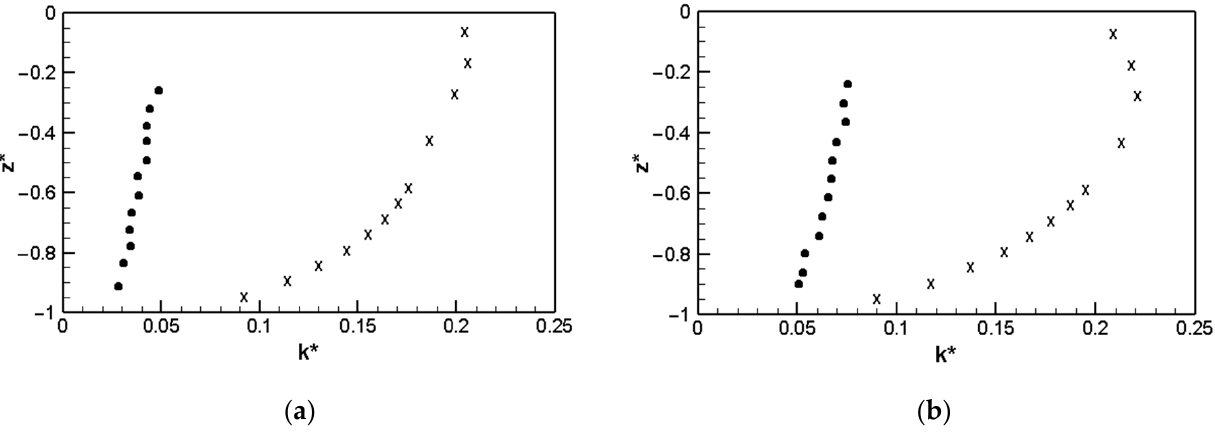
Figure 12. Result 5: time mean turbulent kinetic energy profiles in Configuration WK, showing numerical results (X) and experimental results (circles) [3]. ( a ) x = 7.27 m, ( b ) x = 7.88 m, z ∗ = ( z − η ) / H and k ∗ = k / gH .